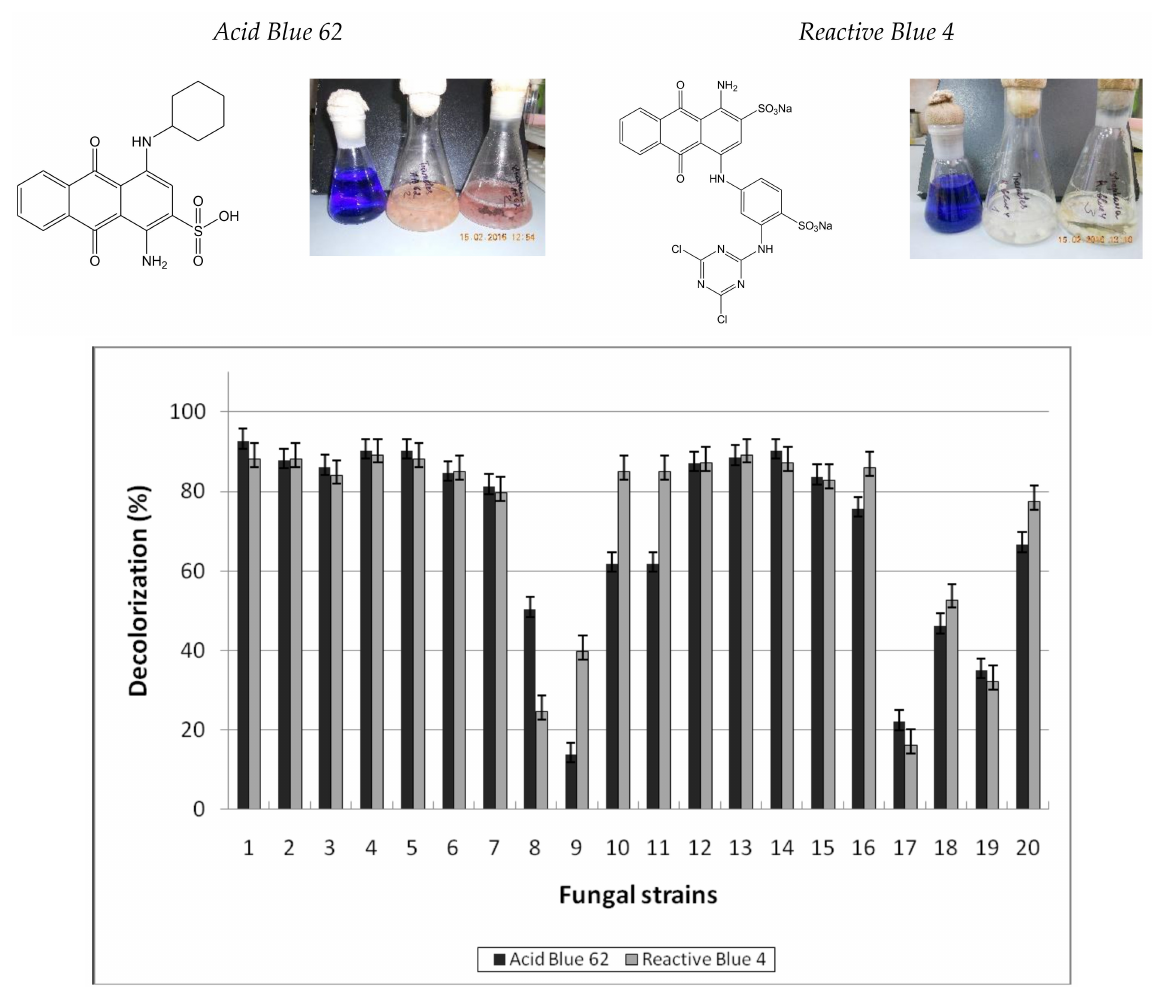
Figure 2. Anthraquinone dyes decolorization after 2 days’ cultivation of the studied fungi: 1—